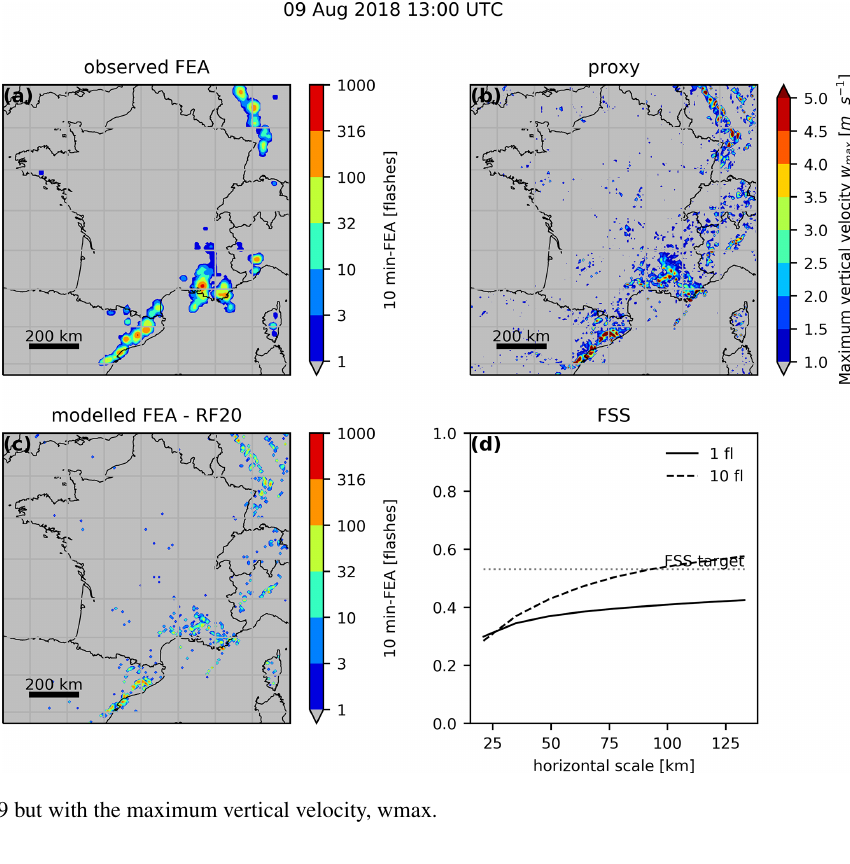
Figure 10. As in Fig. 9 but with the maximum vertical velocity, wmax.